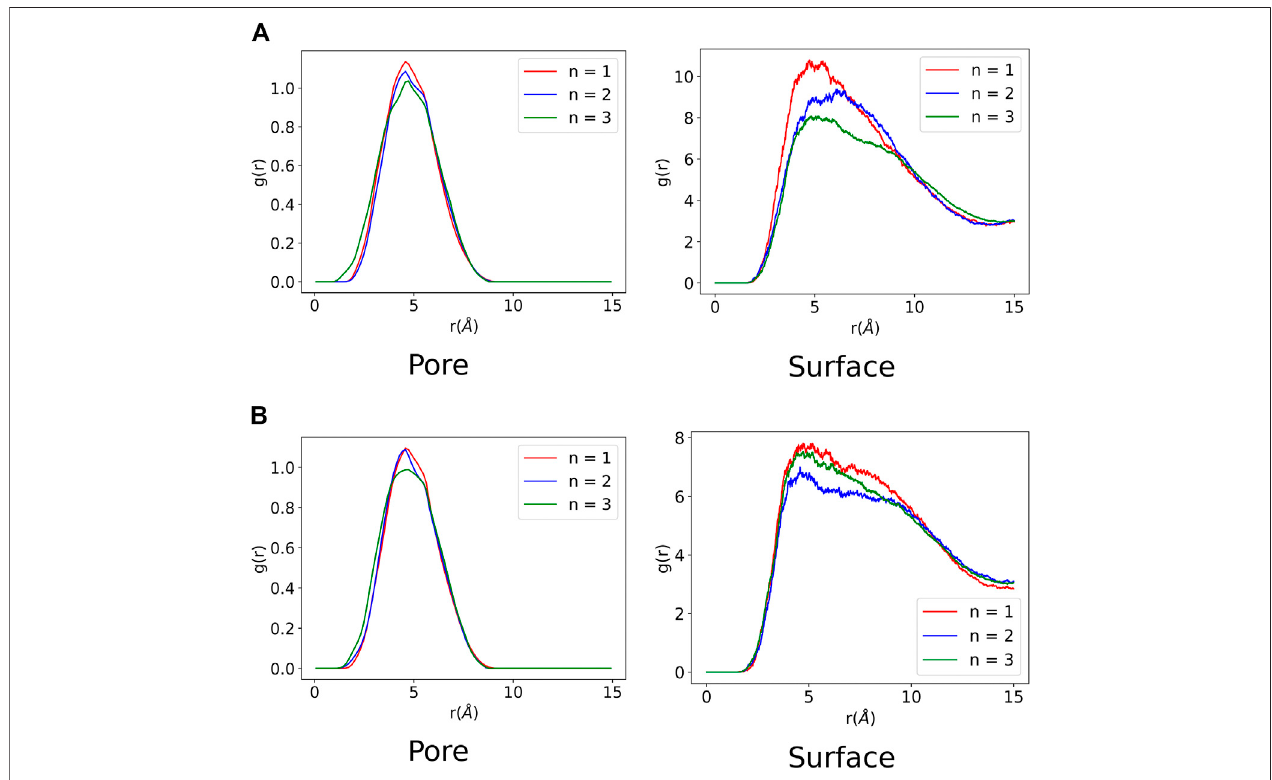
FIGURE 5 | Radial distribution function of ZnPW I monomer(s) interactions computed from each molecular dynamic trajectory. n corresponds to the number of monomer(s) present in the trajectory. The labels ” Pore ” and ” Surface ” correspond to nanochannel and surface interactions respectively. (A) Nanochannel and surface ZnPW_EDOT radial distribution function. (B) Nanochannel and surface ZnPW_styrene radial distribution function.